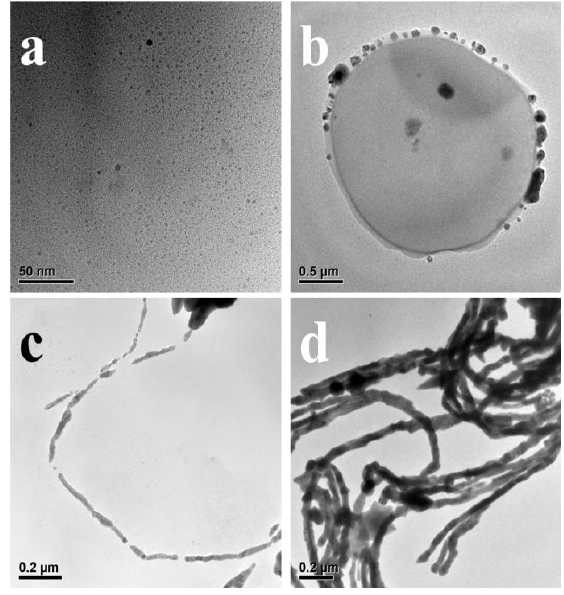
Figure 7. TEM images of Au-Ag nanostructures synthesized through the reduction for ( a ) 0 min; ( b ) 10 min; ( c ) 30 min and ( d ) 300 min. 10 min; ( c ) 30 min and ( d ) 300